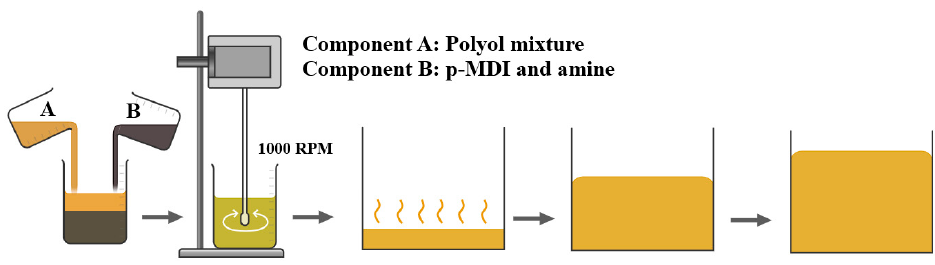
Figure 1. Schematic representation of the RPUF manufacturing.